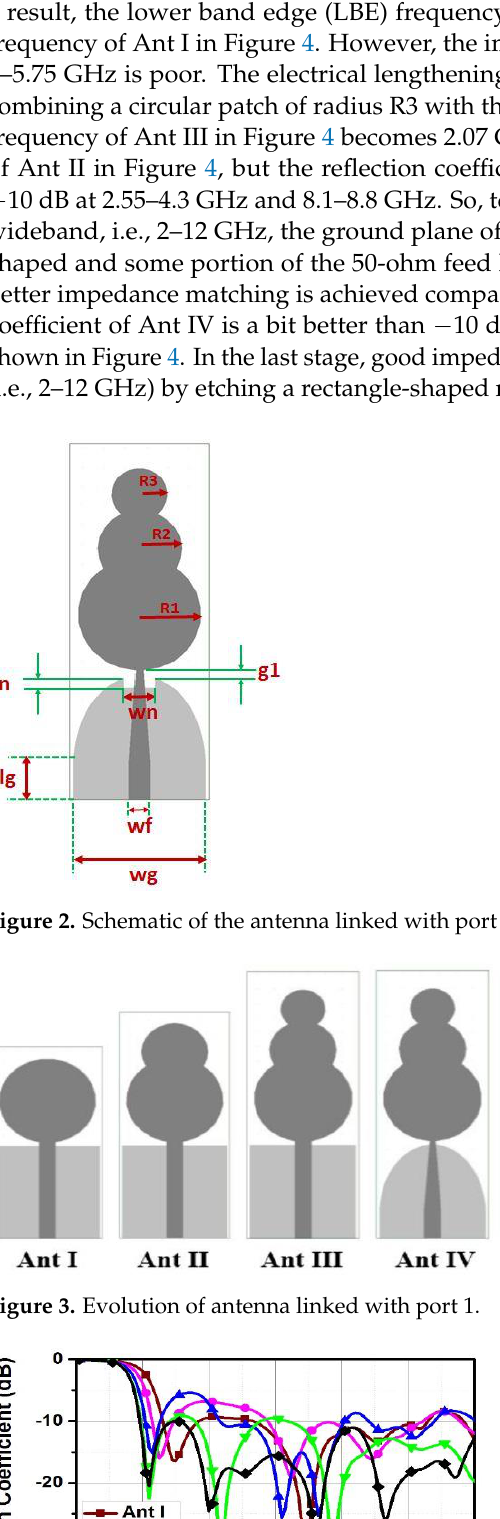
Figure 4. Evolution of the antenna linked with port 1.